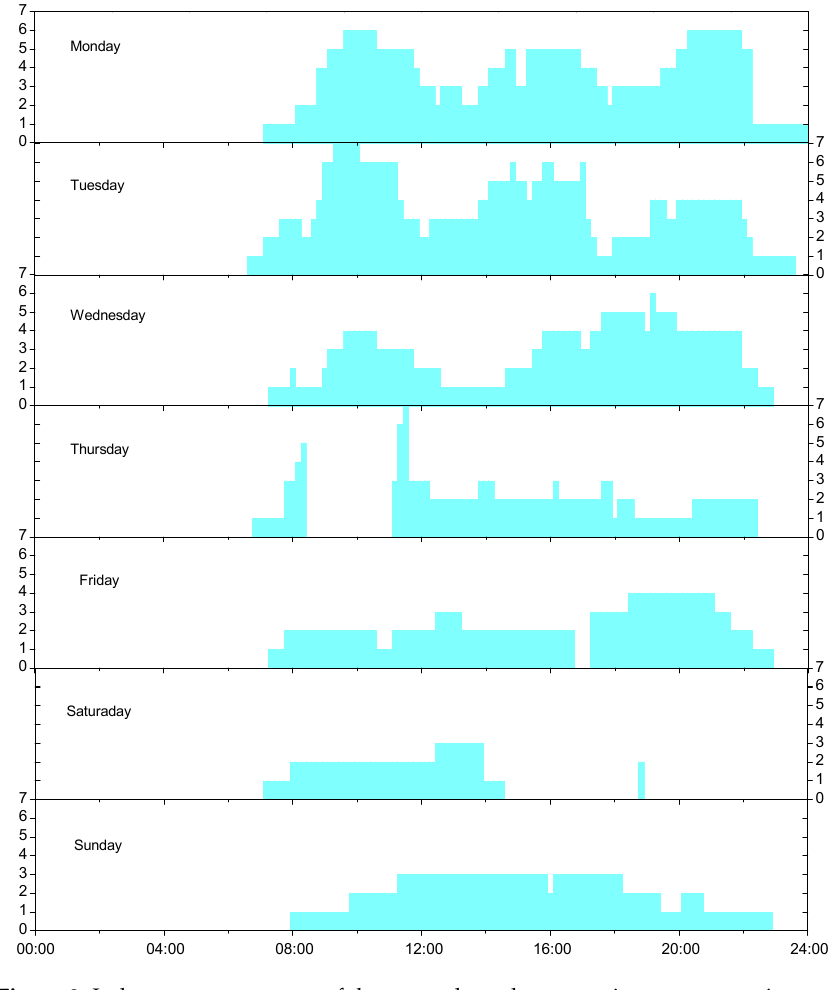
Figure 9. Indoor occupancy case of the research student room in a representative week.